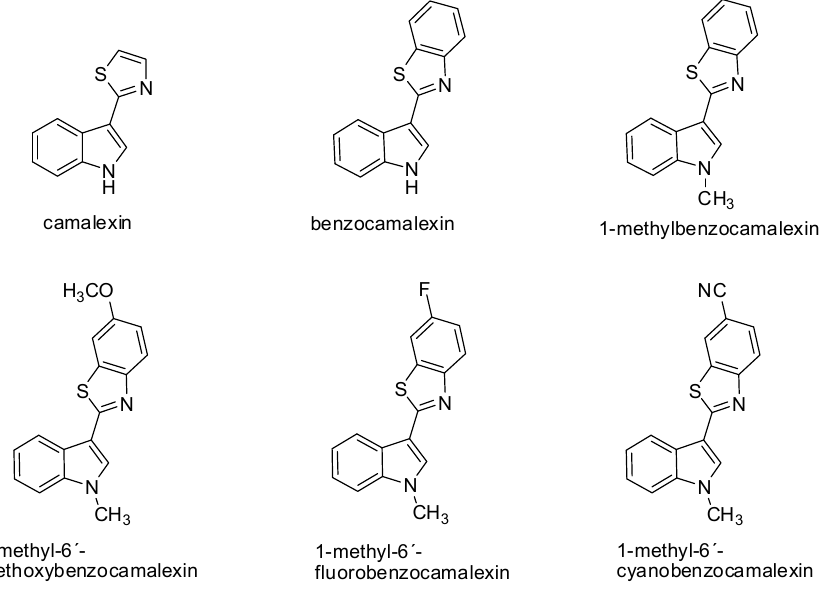
Figure 2. Chemical structure of camalexin and its synthetic analogs.